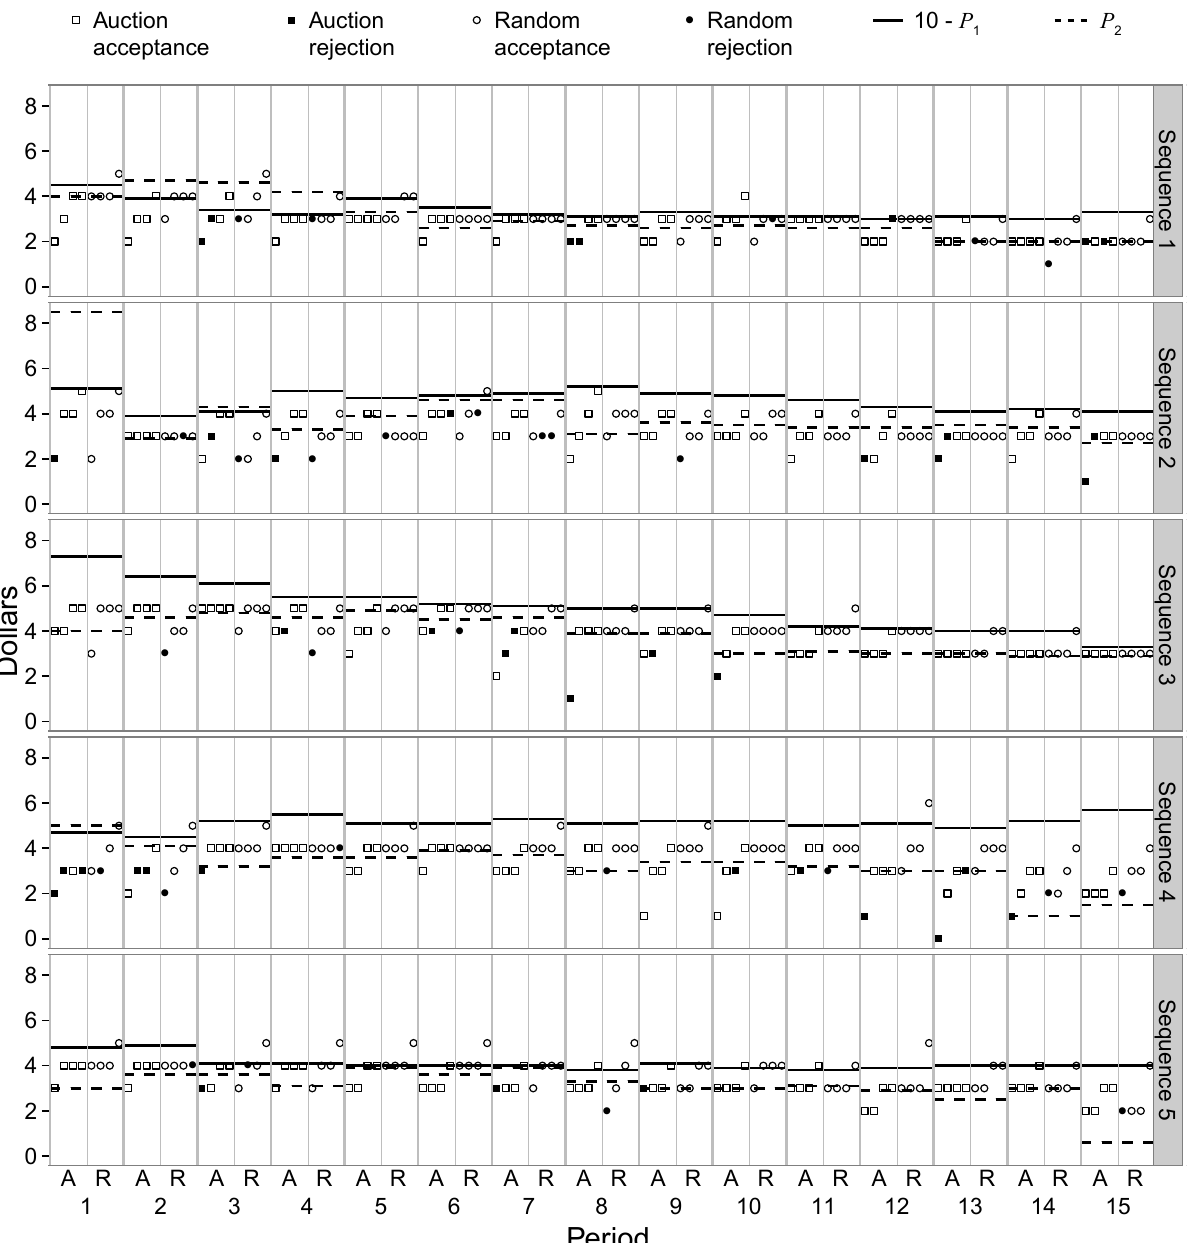
Figure 4. All play in Ultimatum Games with 10 − P